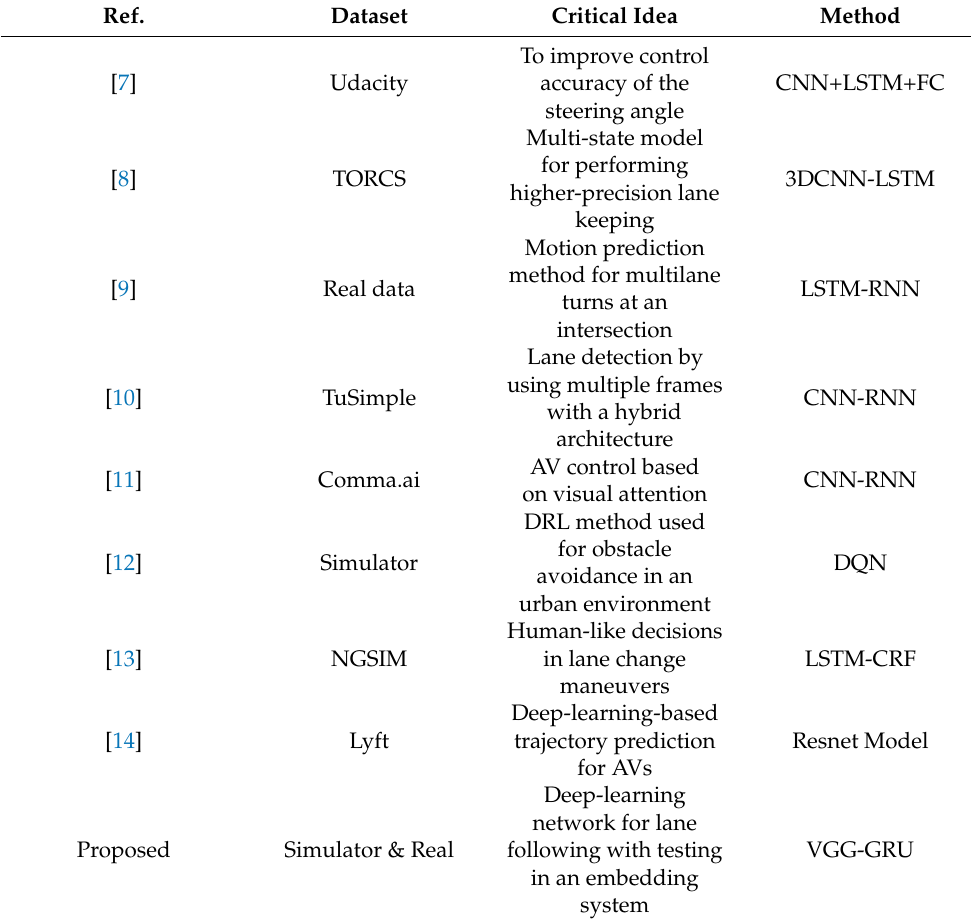
Table 1. Table summarizing the existing studies in terms of their datasets, critical ideas, and methods for comparison with the proposed framework. Ref. Dataset Critical Idea